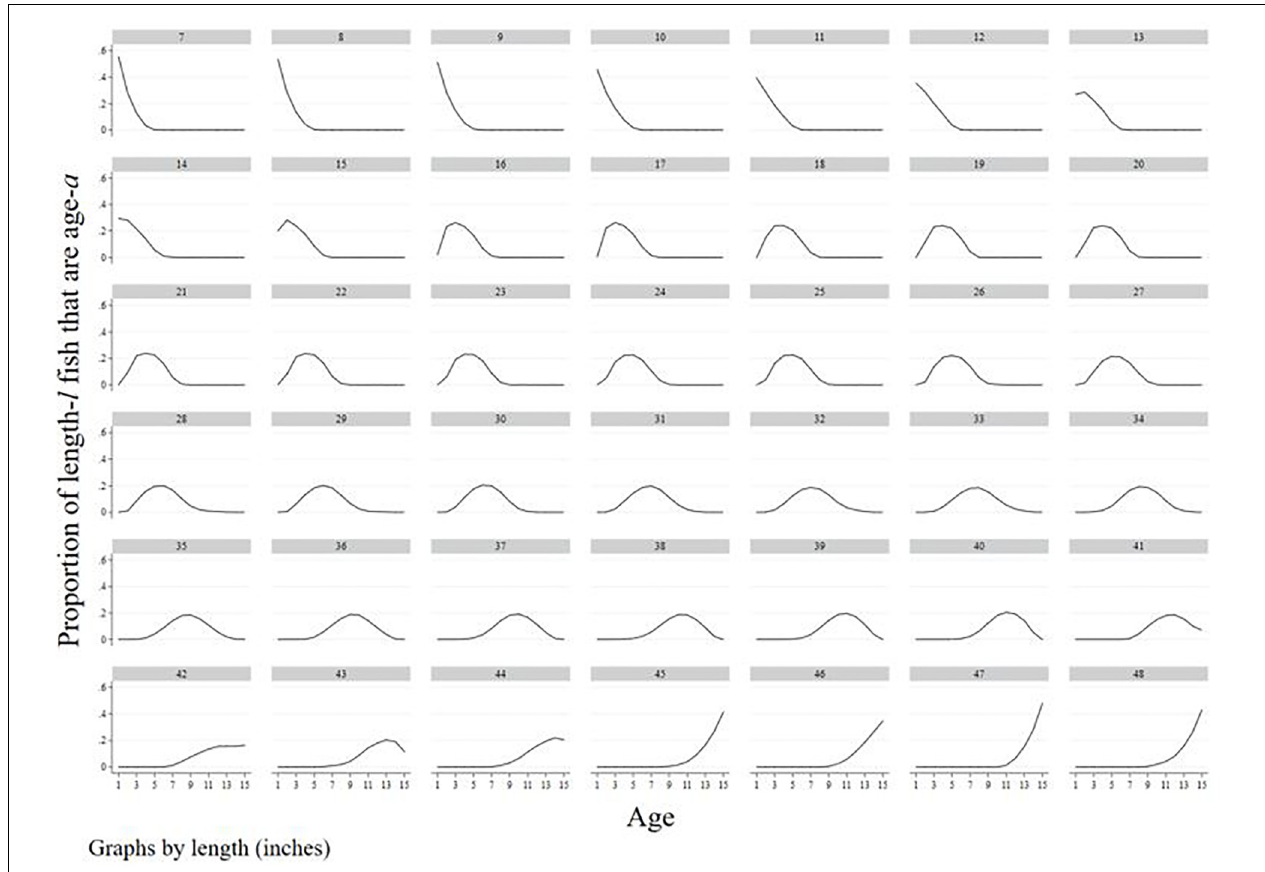
FIGURE 5 | 2015 striped bass length-age conversions by